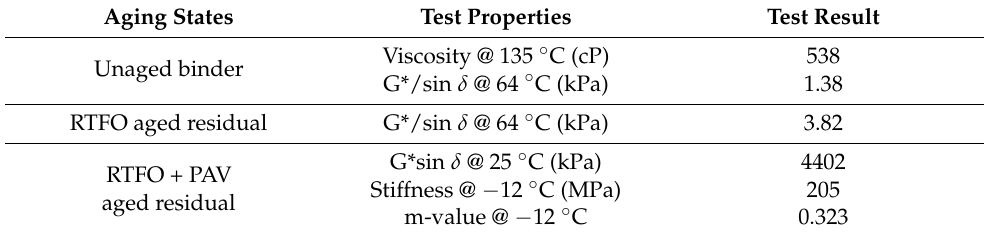
Table 1. Properties of base asphalt binder (PG 64-22).